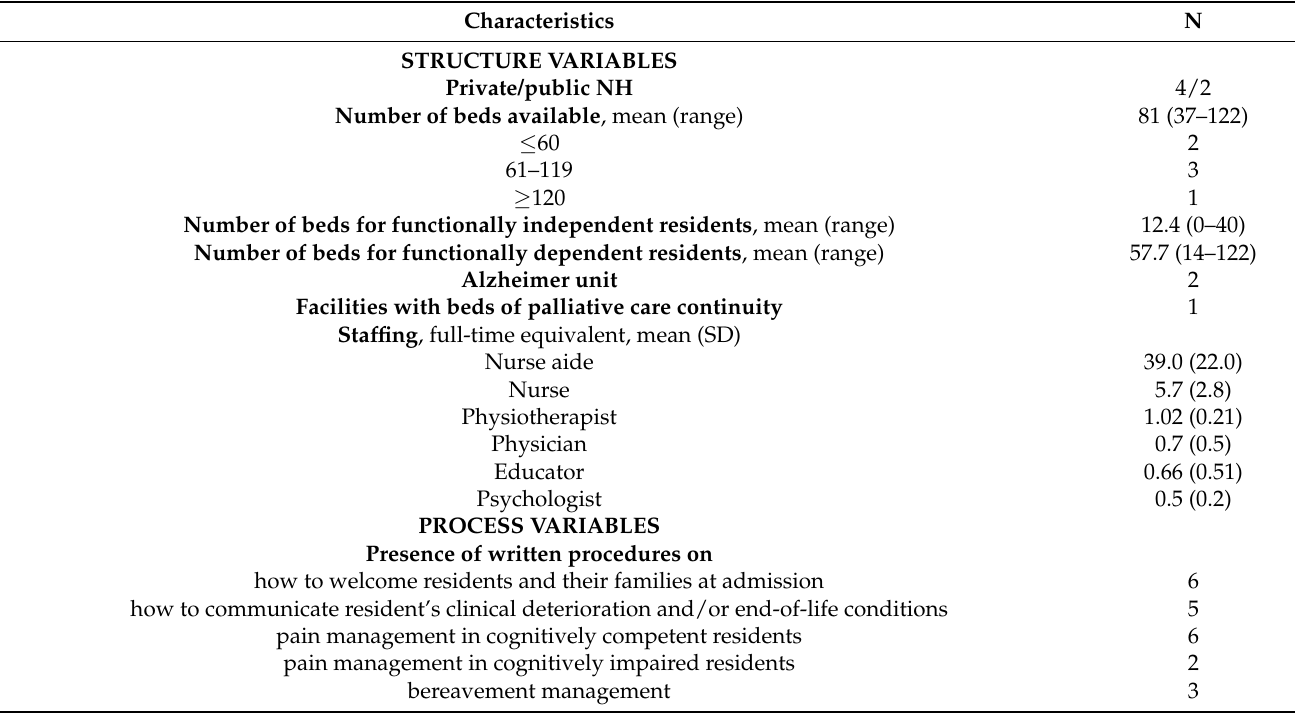
Table 1. Characteristics of nursing homes adhering to the study ( n = 6).